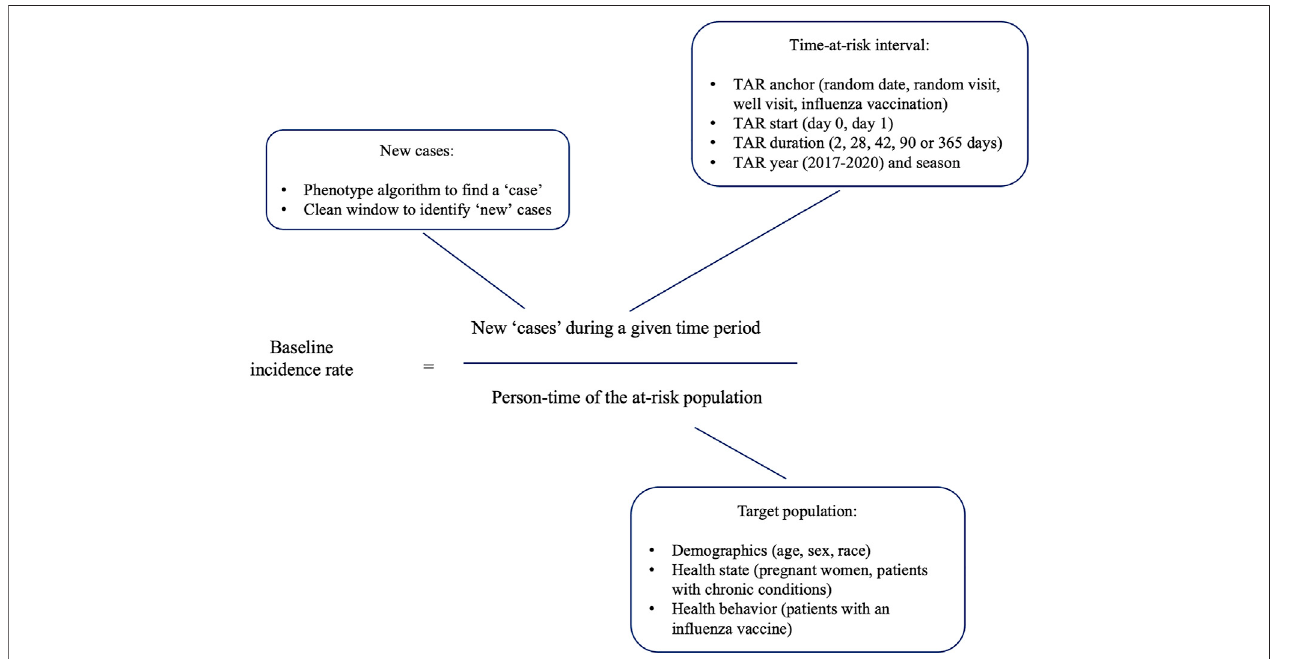
FIGURE 1 | Baseline incidence rate calculation and its